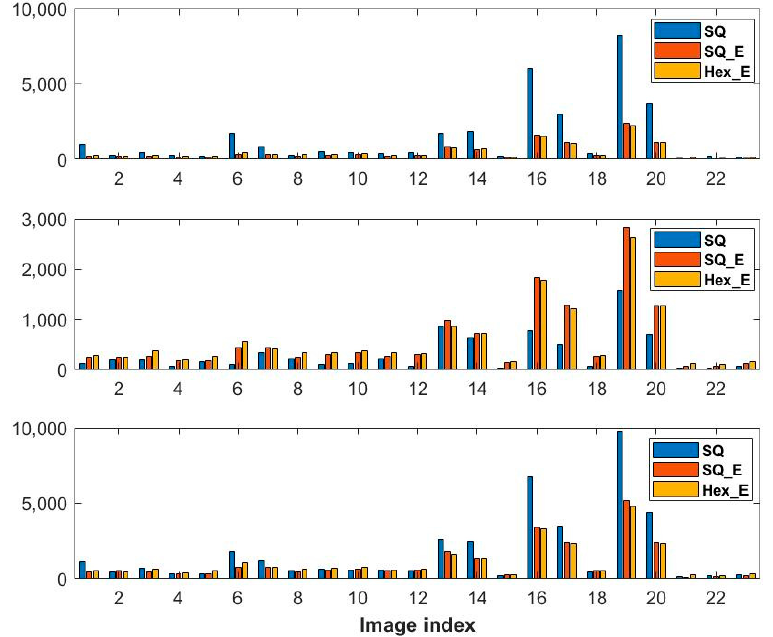
Figure 11. The number of the common saddle ( Top ), extremum points ( Middle ) and the critical points ( Bottom ) between SC and CC image pairs having Hex_E, SQ_E and SQ image types. The normalized nonlinear dissimilarity measurement values of (cid:1844) (cid:3046)(cid:3028)(cid:3031)(cid:3031)(cid:3039)(cid:3032) and (cid:1844) (cid:3032)(cid:3051)(cid:3047)(cid:3045)(cid:3032)(cid:3040)(cid:3048)(cid:3040) for SC